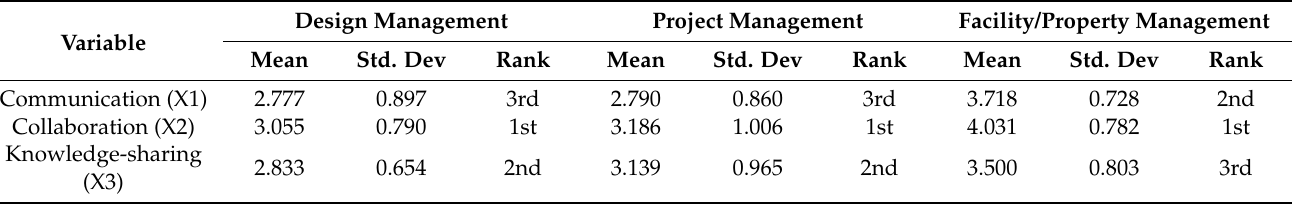
Table 3. Value of mean and standard deviation for the stakeholder design management, project management, and facility